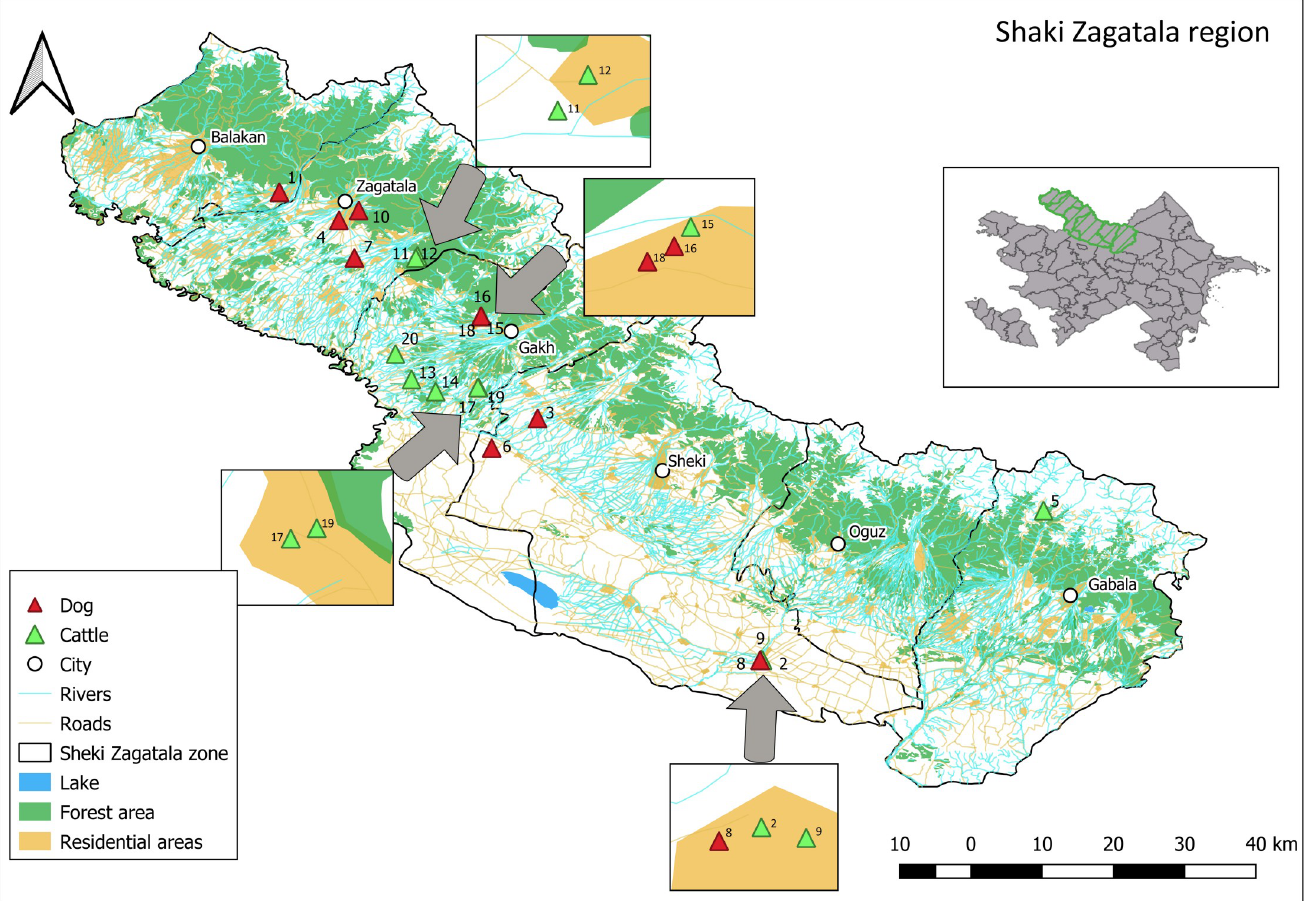
Fig 1. Registered cattle and dog rabies cases in Sheki-Zagatala districts for 2015 and 2016. Base map and data from OpenStreetMap and OpenStreetMap Foundation.